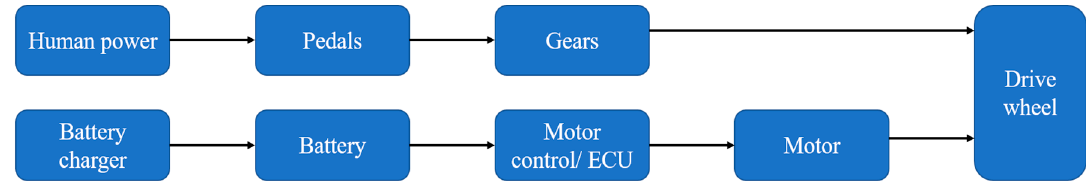
Figure 1. Power train of electrical bicycle.